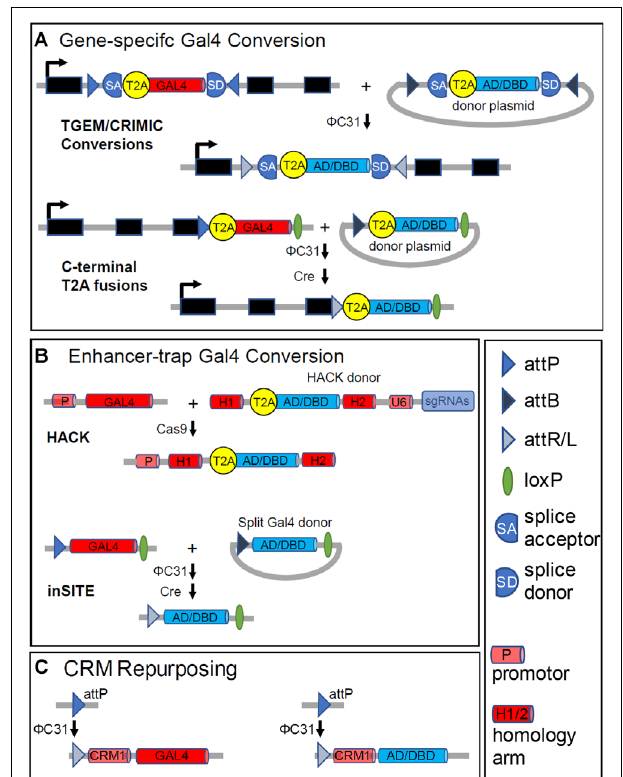
FIGURE 4 | Generating Split Gal4 hemidrivers from Gal4 drivers. While Split Gal4 hemidriver lines can be generated directly, in most instances a Gal4 driver with a desired pattern of expression serves as an intermediate. These starting Gal4 drivers fall into three classes: (A) “gene-trap” Gal4 lines with gene-specific expression; (B) enhancer-trap Gal4 lines made by transposon-mediated transformation; and (C) CRM-Gal4 lines that use enhancer-containing cis-regulatory modules with defined sequences. (A) Gene-trap drivers typically couple Gal4 expression to that of a native gene using T2A peptides (see text). T2A-Gal4 constructs are inserted either intronically, as in TGEM or CRIMIC lines (top), or just before the stop codon in the coding sequence (bottom). In both cases, the inclusion of either attP sites or an attP and a loxP site flanking the inserted constructs permits conversion of the Gal4 line into a Split Gal4 hemidriver. A Zip + -AD or Zip − -Gal4DBD donor construct with complementary flanking attB sites (or an attB and loxP site) can be substituted for Gal4, as indicated. (B) Top panels: the CRISPR/Cas-based HACK method (Lin and Potter, 2016; Xie et al., 2018) can be used to convert arbitrary enhancer-trap Gal4 drivers into Split Gal4 hemidrivers using a universal donor construct. The HACK donor construct has a T2A- Zip + -AD or -Zip − -DNA-BINDING (DBD) sequence flanked by homology arms (H1 and H2) taken from the Gal4 coding sequence. Also, the donor construct has an expression module for guide RNAs targeted to sites in the Gal4 sequence separating H1 and H2. Cas9-mediated cleavage of Gal4 at these sites, followed by homology-directed repair inserts the desired T2A-Split Gal4 construct in-frame into the—now broken—Gal4 sequence. Bottom panels: Enhancer-trap Gal4 lines made using the inSITE system (Gohl et al., 2011) can be converted into Split Gal4 hemidrivers by a series of genetic crosses. The system uses a set of three recombinases (Flp is omitted from the